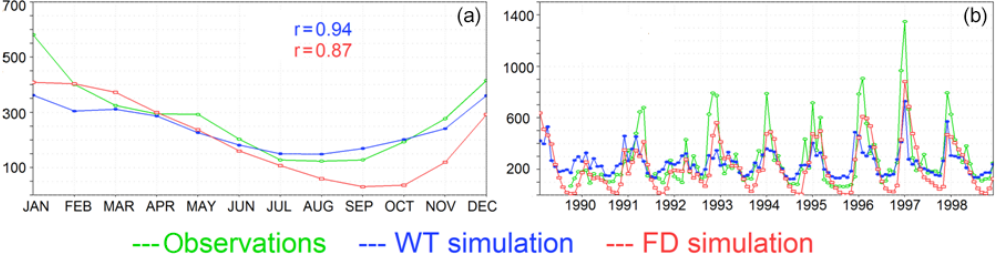
Figure 16. Modelled and observed river flow for the Ebro station 6 in Fig. 6. (a) Monthly mean river flow (m 3 s − 1 ) and correlation indexes between the observed and simulated time series (we used the mean seasonal cycle for the index). (b) Monthly river flow (m 3 s − 1 ). Blue for the WT simulation, red for the FD simulation and green for